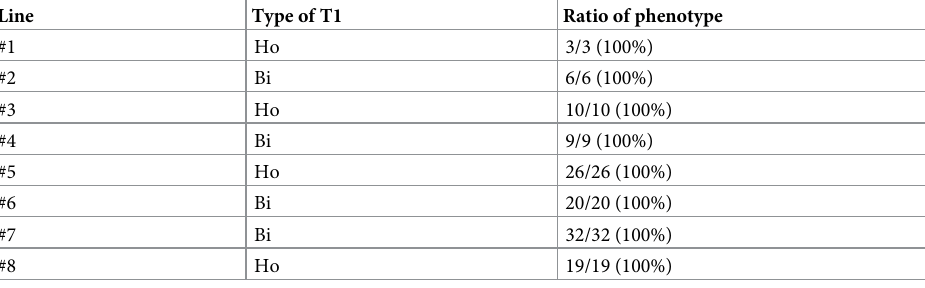
Table 1. Analysis of transmittable mutants in T2 generation.